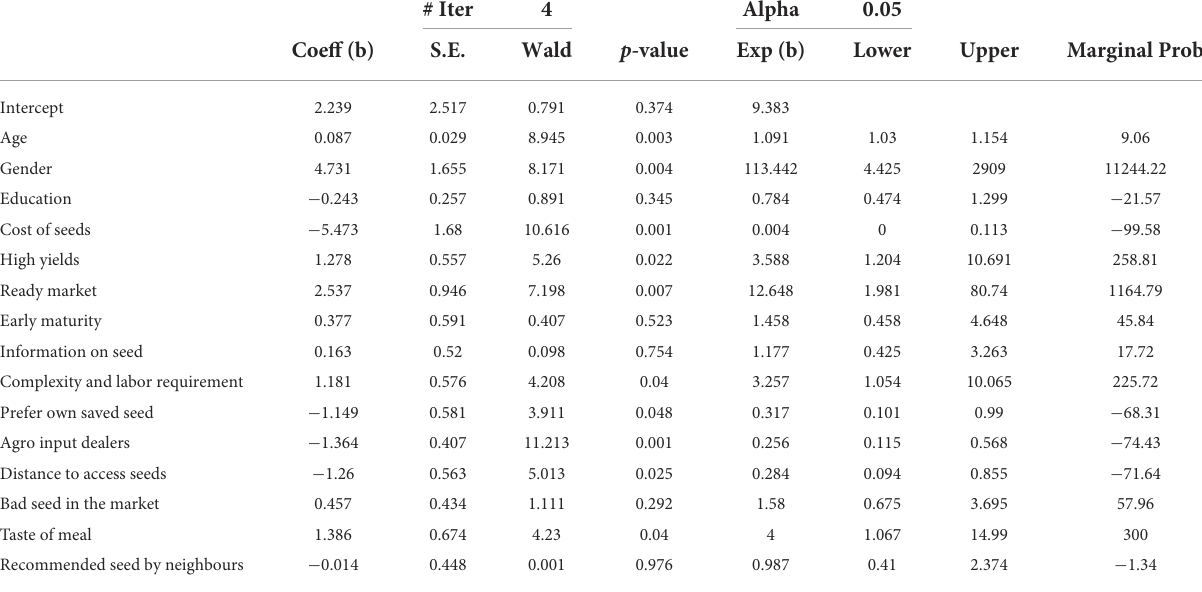
TABLE 5 Linear Logistics regression computations for technology adoption